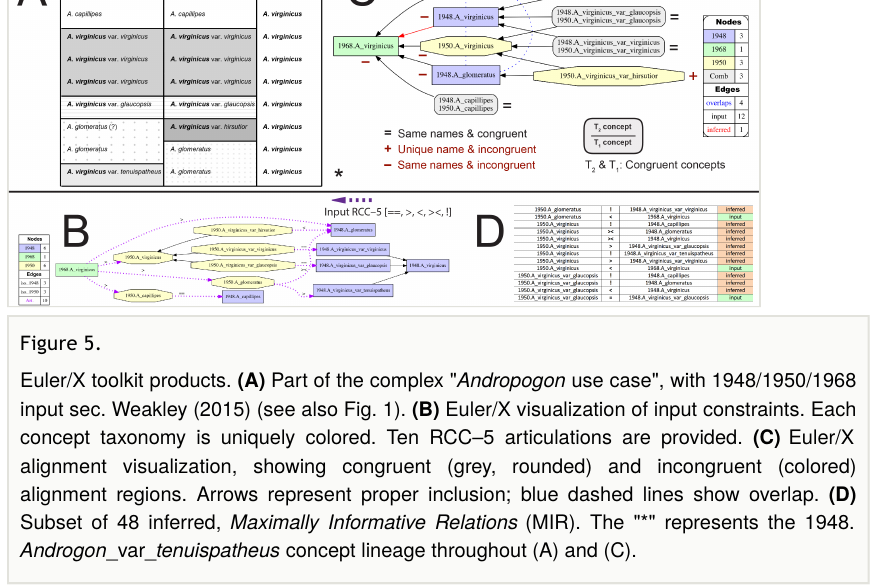
means, e.g., that aligning Weakley (2015) with the Flora of North America (FNA 2015) generates 7000 * 5408 = 37,856,000 MIR logically implied by Weakley's input. Thus if we took the 20 most articulated non-Weakley treatments and produced a matrix of reciprocal pairwise alignments for all of them, we would obtain 2,586,545,944 or nearly 2.6 billion MIR.